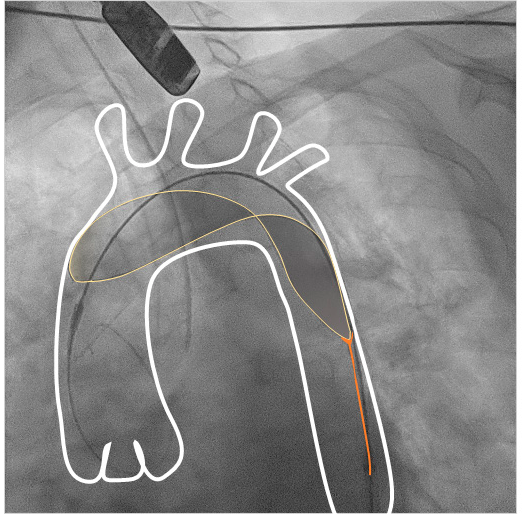
Figure 2. Triguard device in standard position covering the supra-aortic vessels. Anteroposterior view. Aortic arch and supraaortic vessels are depicted in white, the device is depicted in yellow for better visibility.